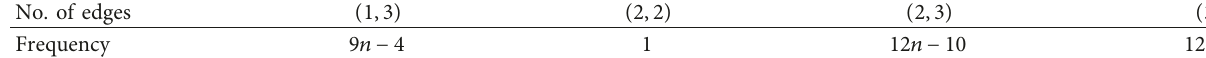
1 using Figure 4. >